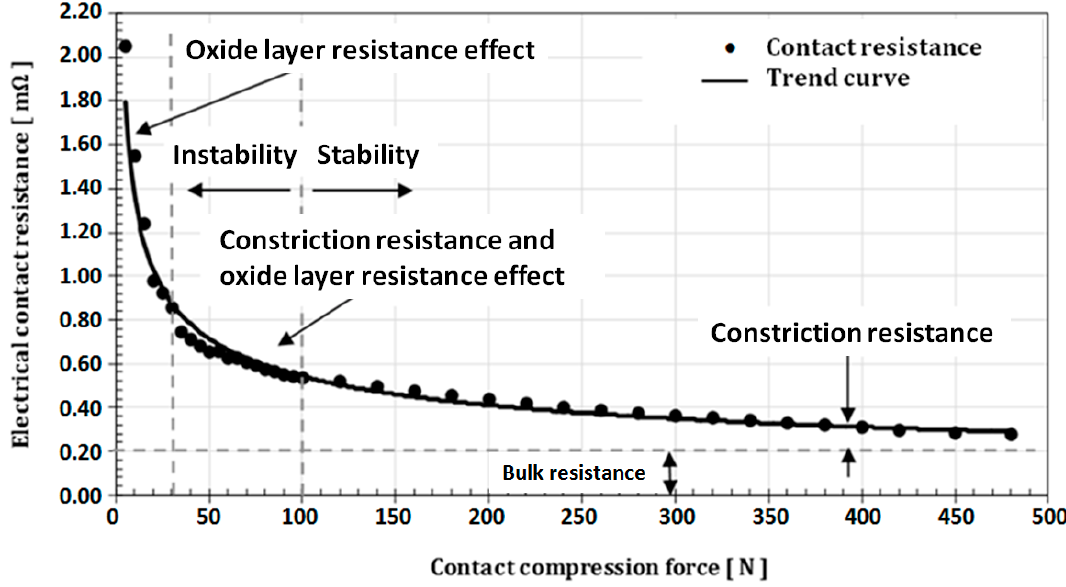
Figure 3. Electrical contact resistance as a function of the compression force (crossing angle of 90°) for copper (measuring current of 10 A, rated voltage drop of 20 mV, the diameter of wire 2.06 mm, crossing angle